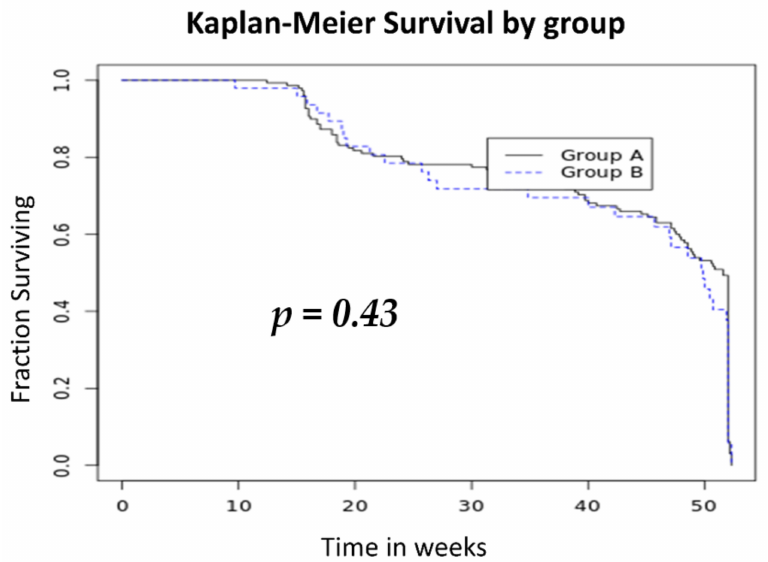
Figure 3. Kaplan–Meier curve of treatment discontinuation-free analysis. Abbreviations: Group A, patients receiving vedolizumab (VZD) as a second-class therapy and ustekinumab (UST) as a third-class therapy; Group B, patients receiving UST as a second-class therapy and VDZ as a third-class